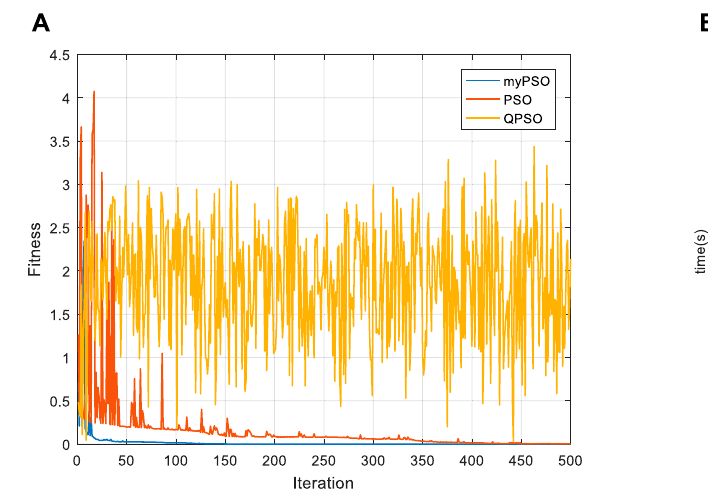
Frontiers in Bioengineering and Biotechnology |